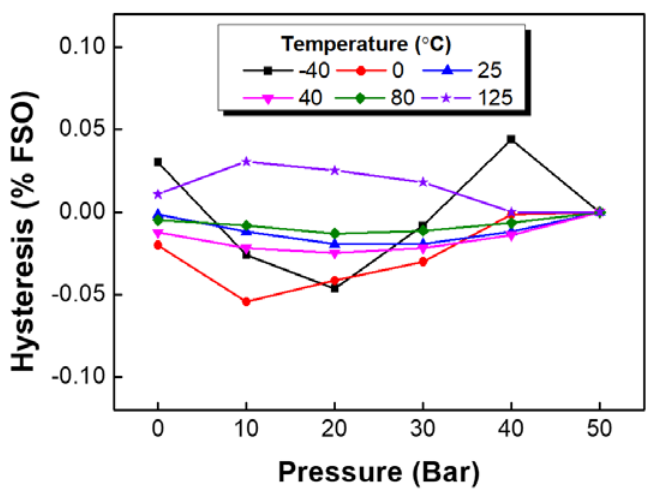
Figure 11. Hysteresis of a bridge circuit outputs at various temperatures and pressures.